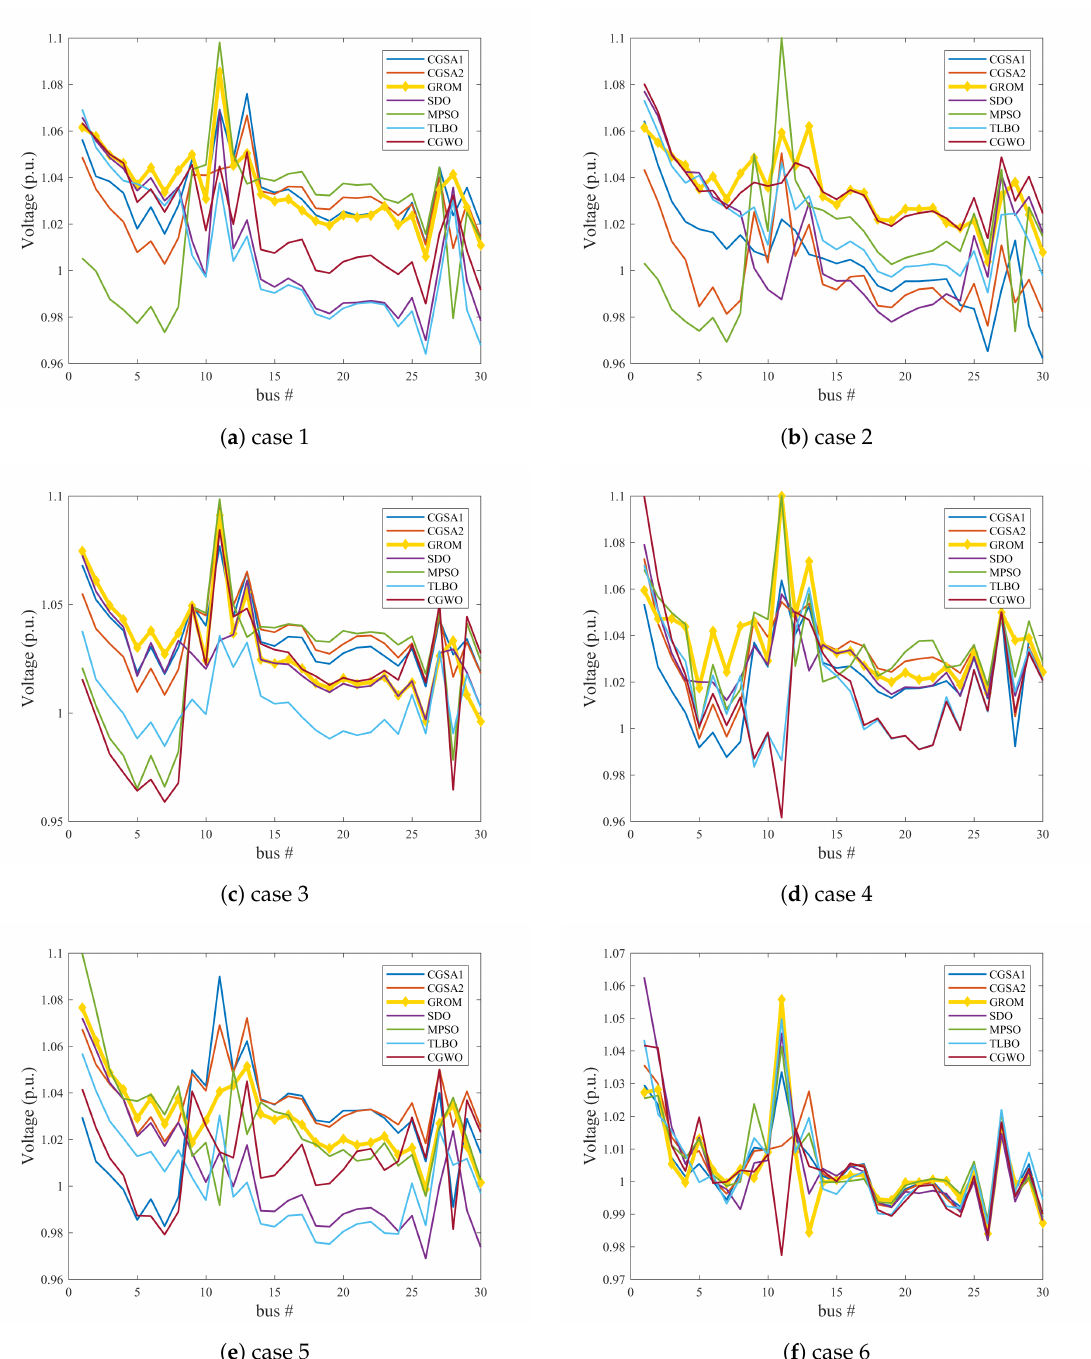
Figure 4. Voltage profile for single-objective optimal power